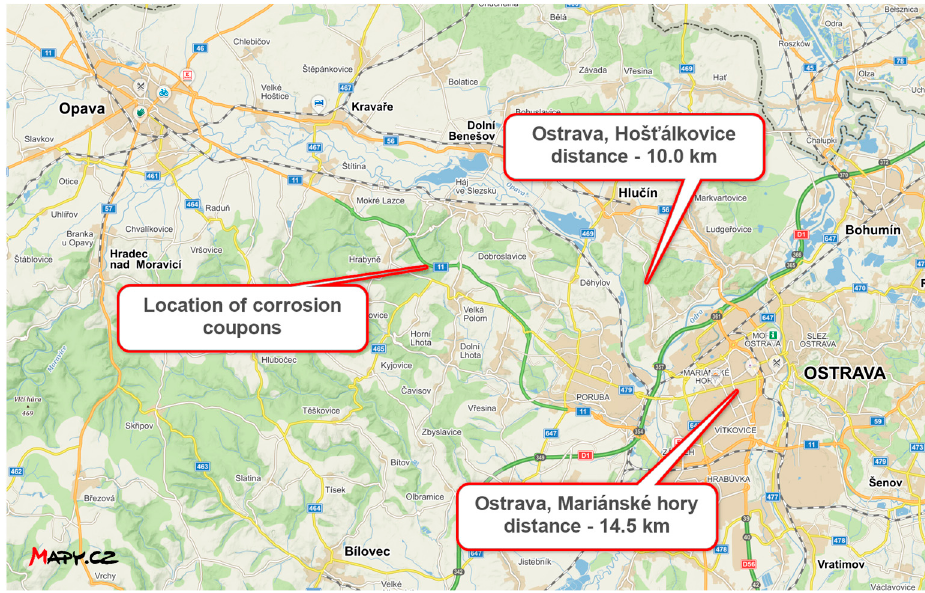
Figure 15. Distance between the position of the corrosion coupons and the CHMI measuring stations (source: mapy.cz).